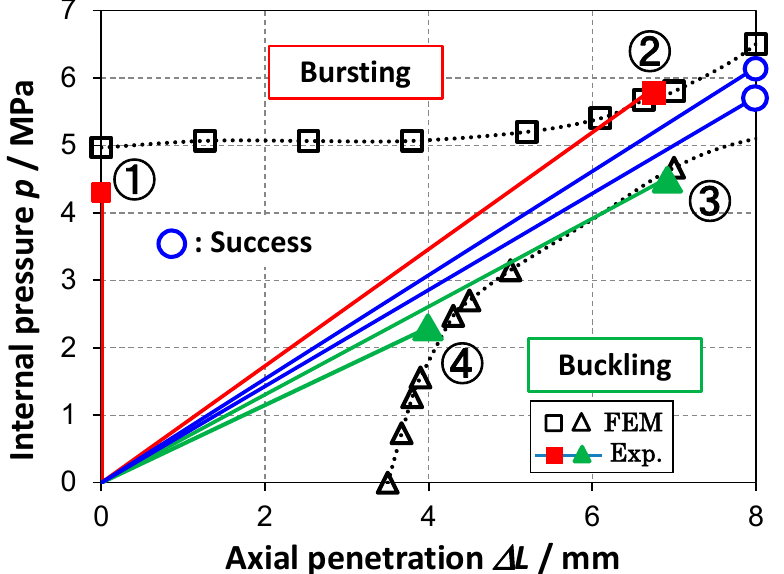
Figure 7. Process window and forming limits of T-shape forming for AZ31B tube in a proportional loading under 250 °C. The ① , ② , ③ , and ④ in the figure indicate different loading paths (ex- periment).